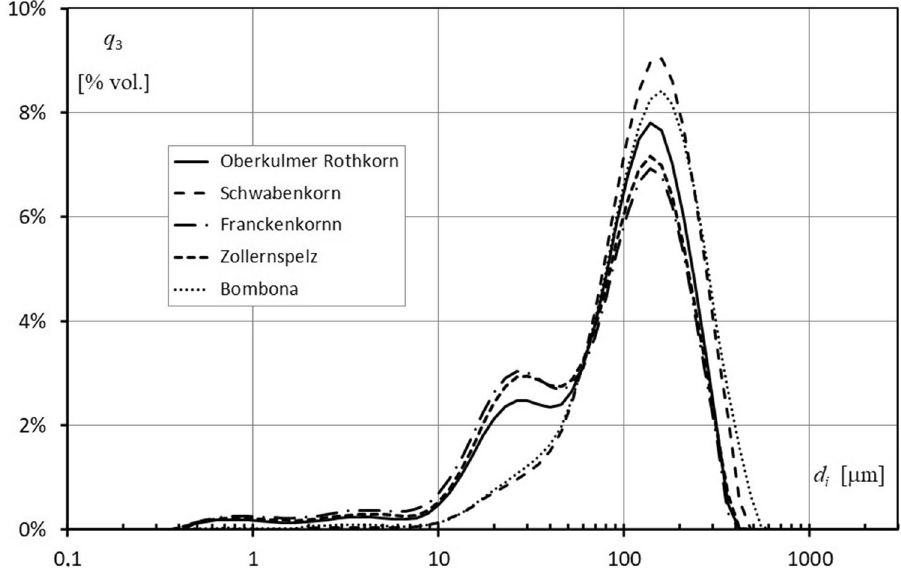
Figure 2. Particle size distribution of spelt and common wheat